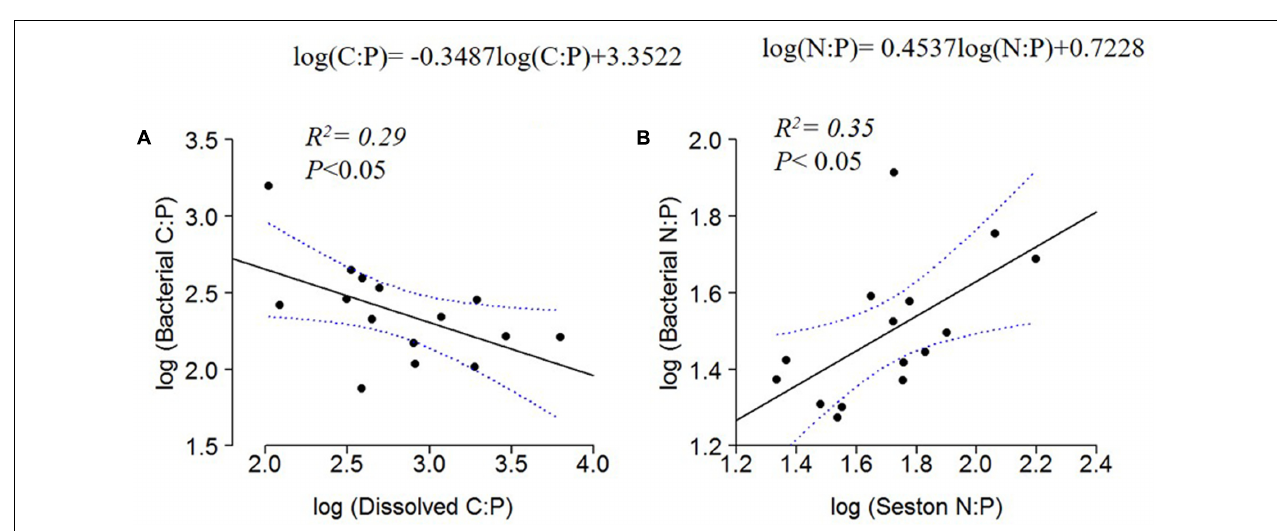
FIGURE 5 | Log 10 linear regressions of ratios of bacterial C:P (A) and N:P (B) against bacterial density (BD), BP against bacterial C:P (C) and N:P (D) and BCD against bacterial C:P (E) and bacterial N:P (F) . The regression fit is indicated by black solid lines and 95% confidence intervals by blue dotted lines.